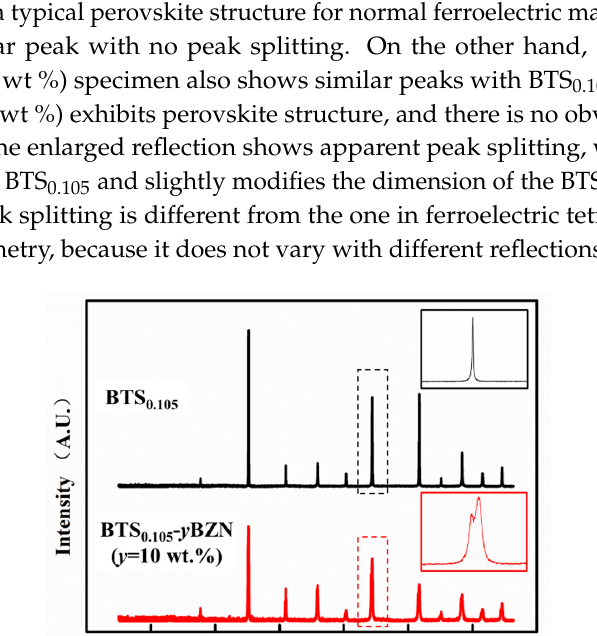
Figure 3. High-resolution X-ray diffraction results for BTS 0.105 and BTS 0.105 − y BZN( y = 10 wt %). Each enlarged reflection is shown in the inset.